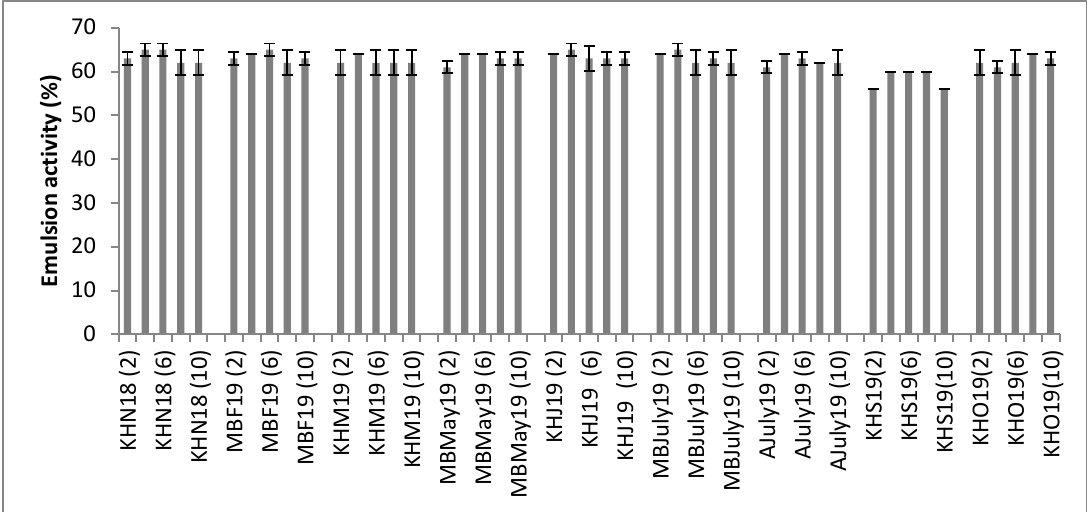
Figure 5. Emulsion activity (%) of various mussel Protamex ® hydrolysates (H) across a pH range of (2) to (10). All 9 samples from the three sampling sites, Mulroy bay (MB), Killary harbor (KH) and Ardgroom (A), collected from November 2018 to October 2019, were used for analysis. No significant difference was found between the average solubility values after Tukey post hoc analysis. Analysis was performed in triplicate (n = 3).